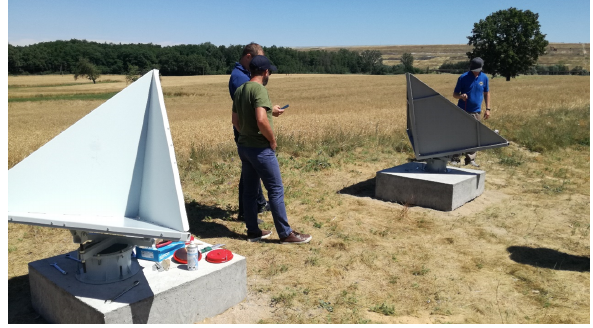
Figure 3. Artificial Passive Corner Reflectors type TRC-T